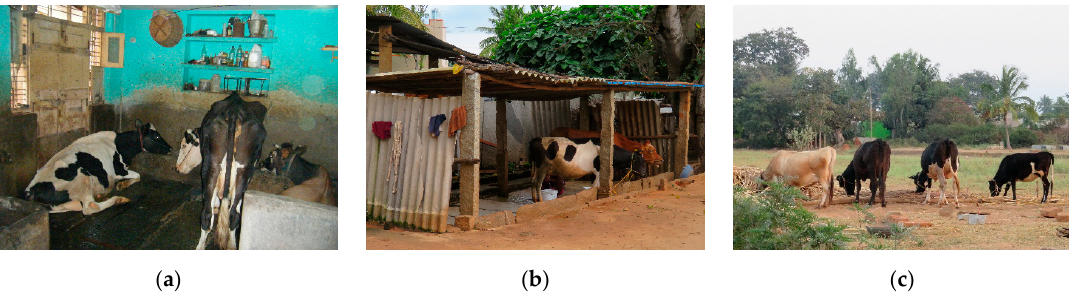
Figure 3. Measurement location for methane emissions: ( a ) Indoor, ( b ) half outdoor and ( c ) outdoor